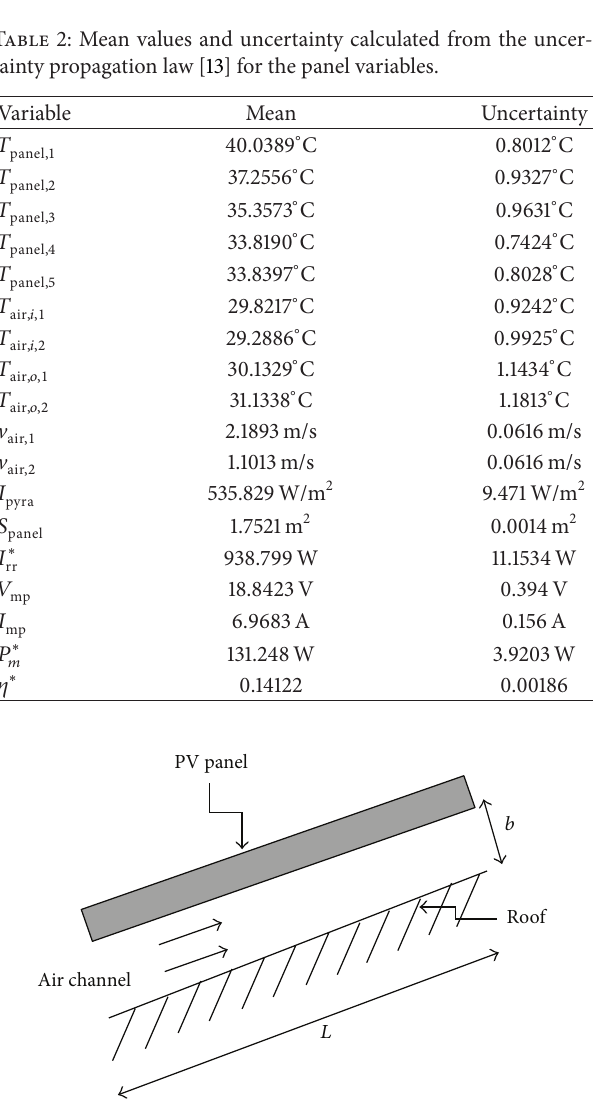
Figure3:ConfigurationofpanelB,showingtheairchannelbetween the PV panel and the